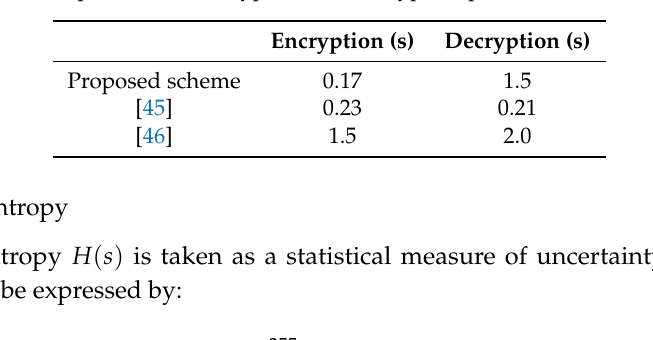
Table 7. Time consumption of the encryption and decryption process for the related references.